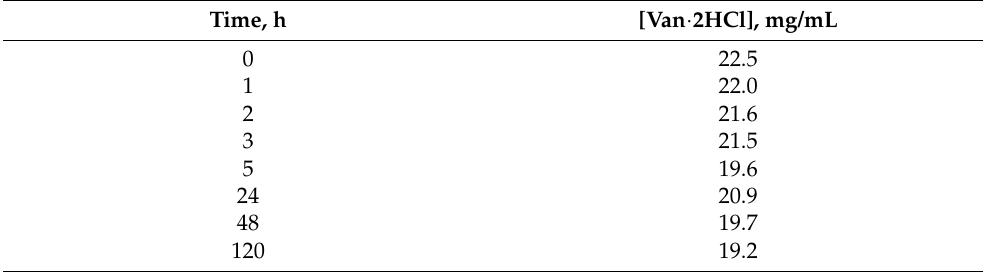
Table 2. Absorption of Van·2HCl (100 mg) by HAp (100 mg) in 5 mL of water.